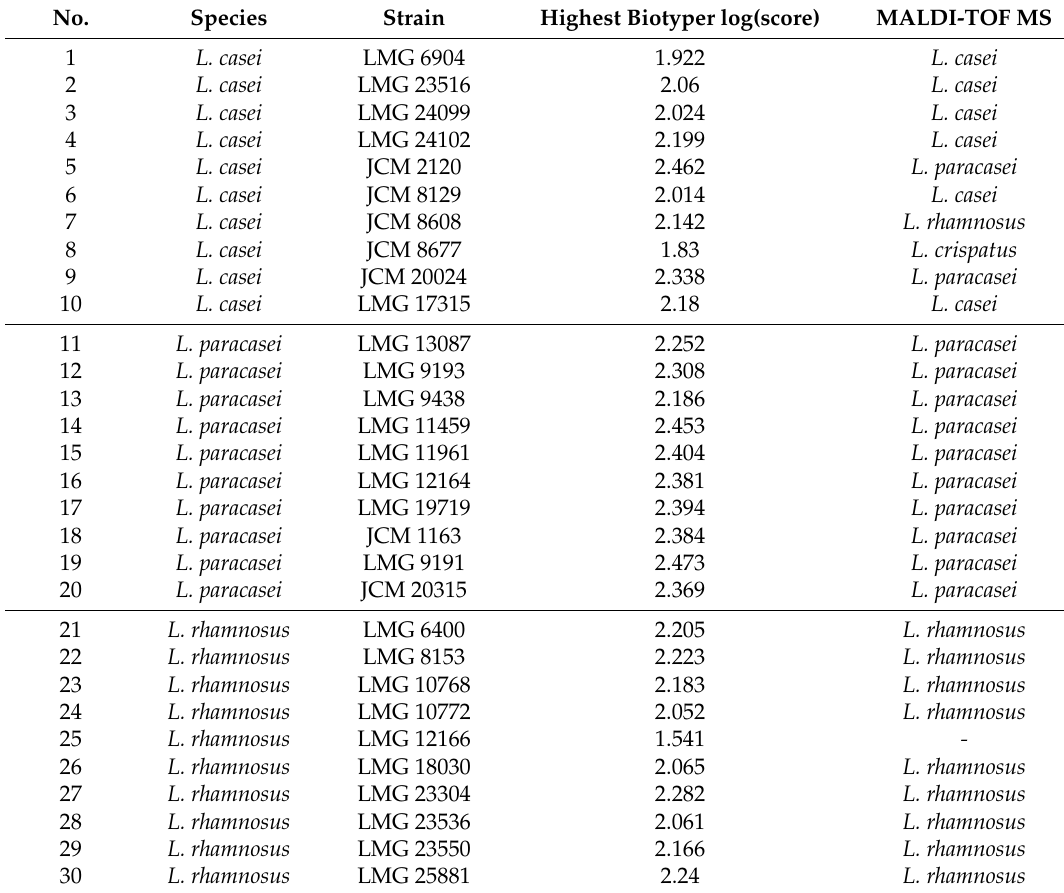
Table 2. Species confirmation of bacterial strains belonging to the L. casei group using MALDI-TOF MS. All experiments were performed in duplicate, the highest log(score) is shown in the table.